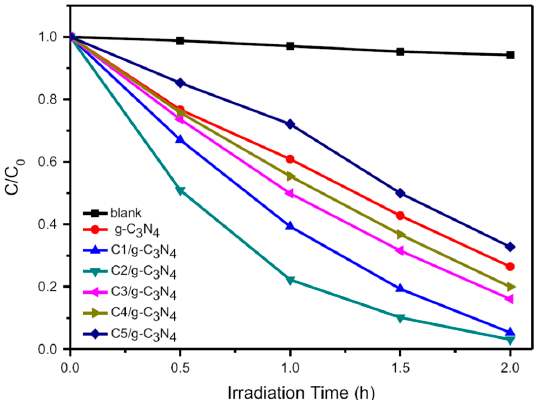
Figure 9. Photocatalytic degradation efficiency of Methylene blue (MB) by graphitic carbon nitride (g-C 3 N 4 ) and C/g-C 3 N 4 composites. From Ref. [79]. Reprinted with permission from Elsevier.